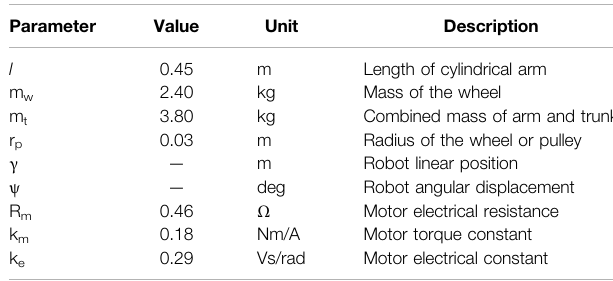
TABLE 1 | Model parameters of the robot.